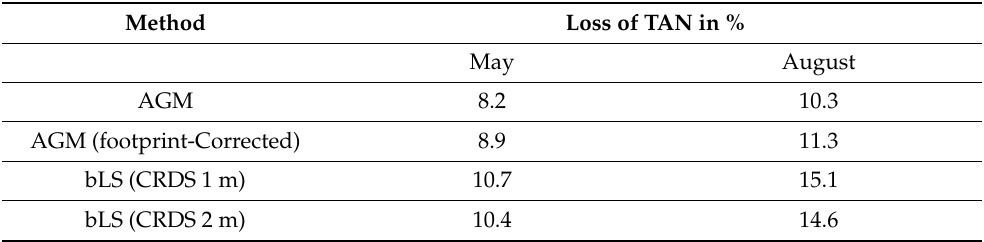
Table 3. Loss of total ammoniacal nitrogen (TAN) in percentage in May and August for the filtered data measurements starting after slurry was applied to the whole field over the measurement period.